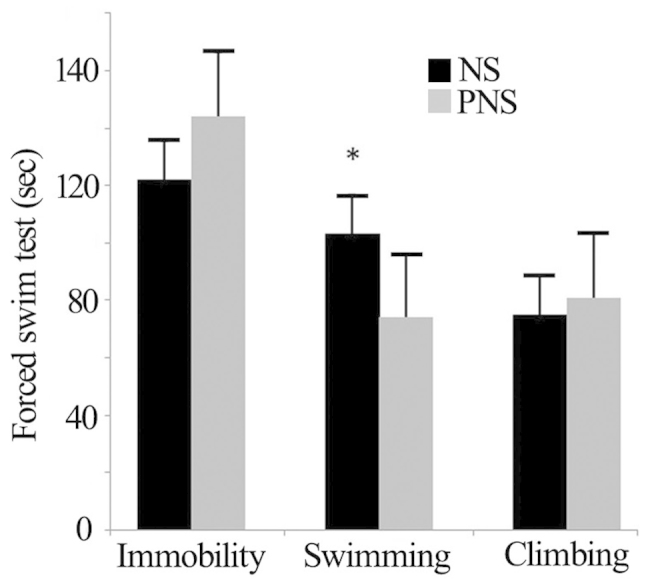
Behavioral response in the forced swim test. Comparison between NS and PNS offspring (n=10 in each group). Marks indicate a decrease in swimming. Data are presented as means ± SEM. *P<0.05. NS, non-prenatal stressed offspring; PNS, prenatal stressed offspring; SEM, standard error of the mean.